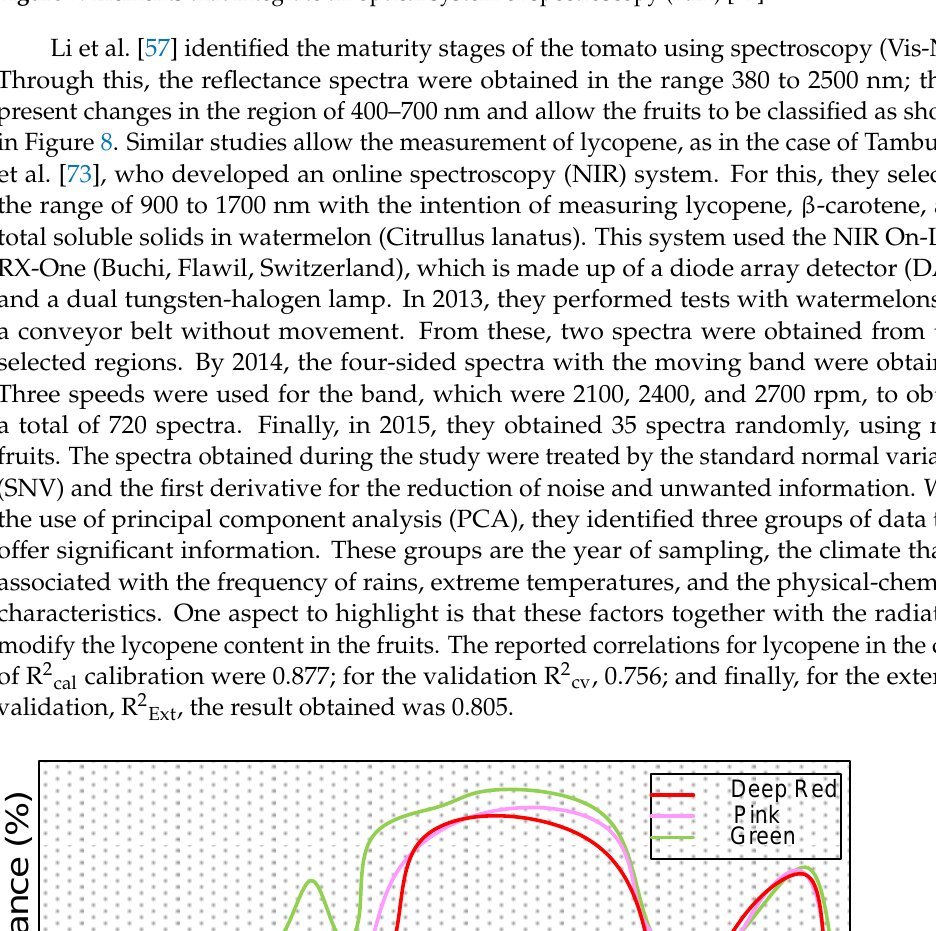
Figure 7. Elements that integrate an optical system of spectroscopy (NIR) [72].